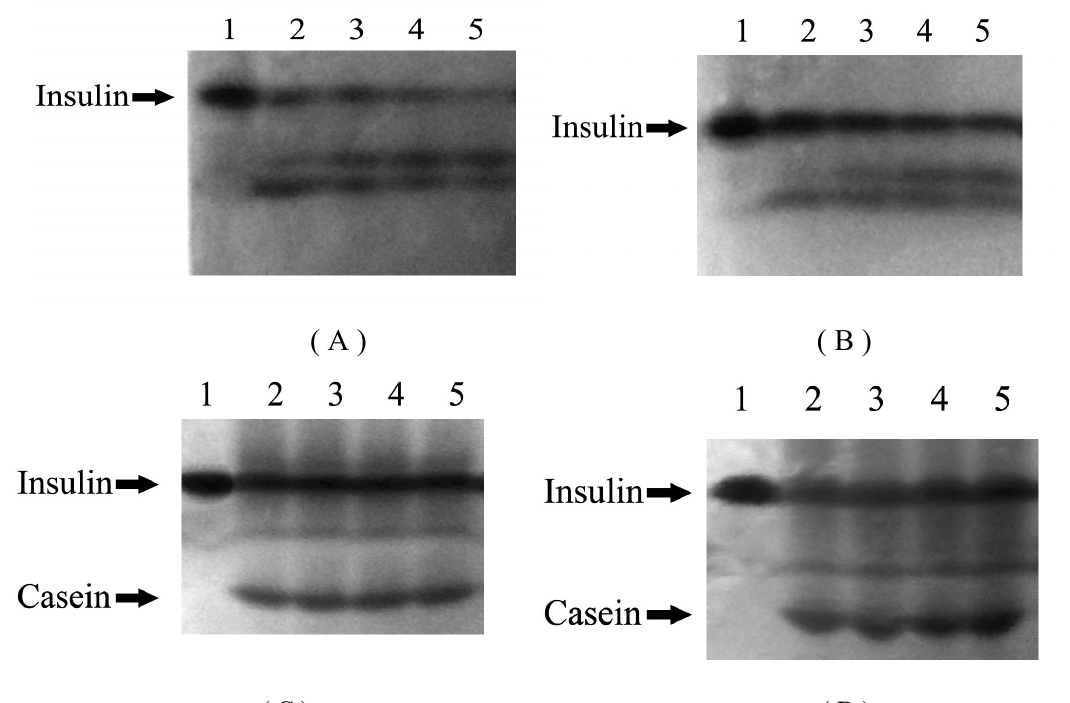
Figure 2. Effects of HP- β -CD and casein on degradation of insulin induced by α -chymotrypsin. Lanes 1-5 in (A) represent insulin incubated with α -chymotrypsin at 37 ºC for 0, 15, 30, 45 and 60 min, respectively; Lanes 1-5 in (B) represent insulin incubated with α -chymotrypsin and HP- β -CD at 37ºC for 0, 15, 30, 45 and 60 min, respectively; Lanes 1-5 in (C) represent insulin incubated with α -chymotrypsin and casein at 37 ºC for 0, 15, 30, 45 and 60 min, respectively; Lanes 1-5 in (D) represent insulin incubated with α -chymotrypsin, HP- β -CD and casein at 37 ºC for 0, 15, 30, 45, 60 min,